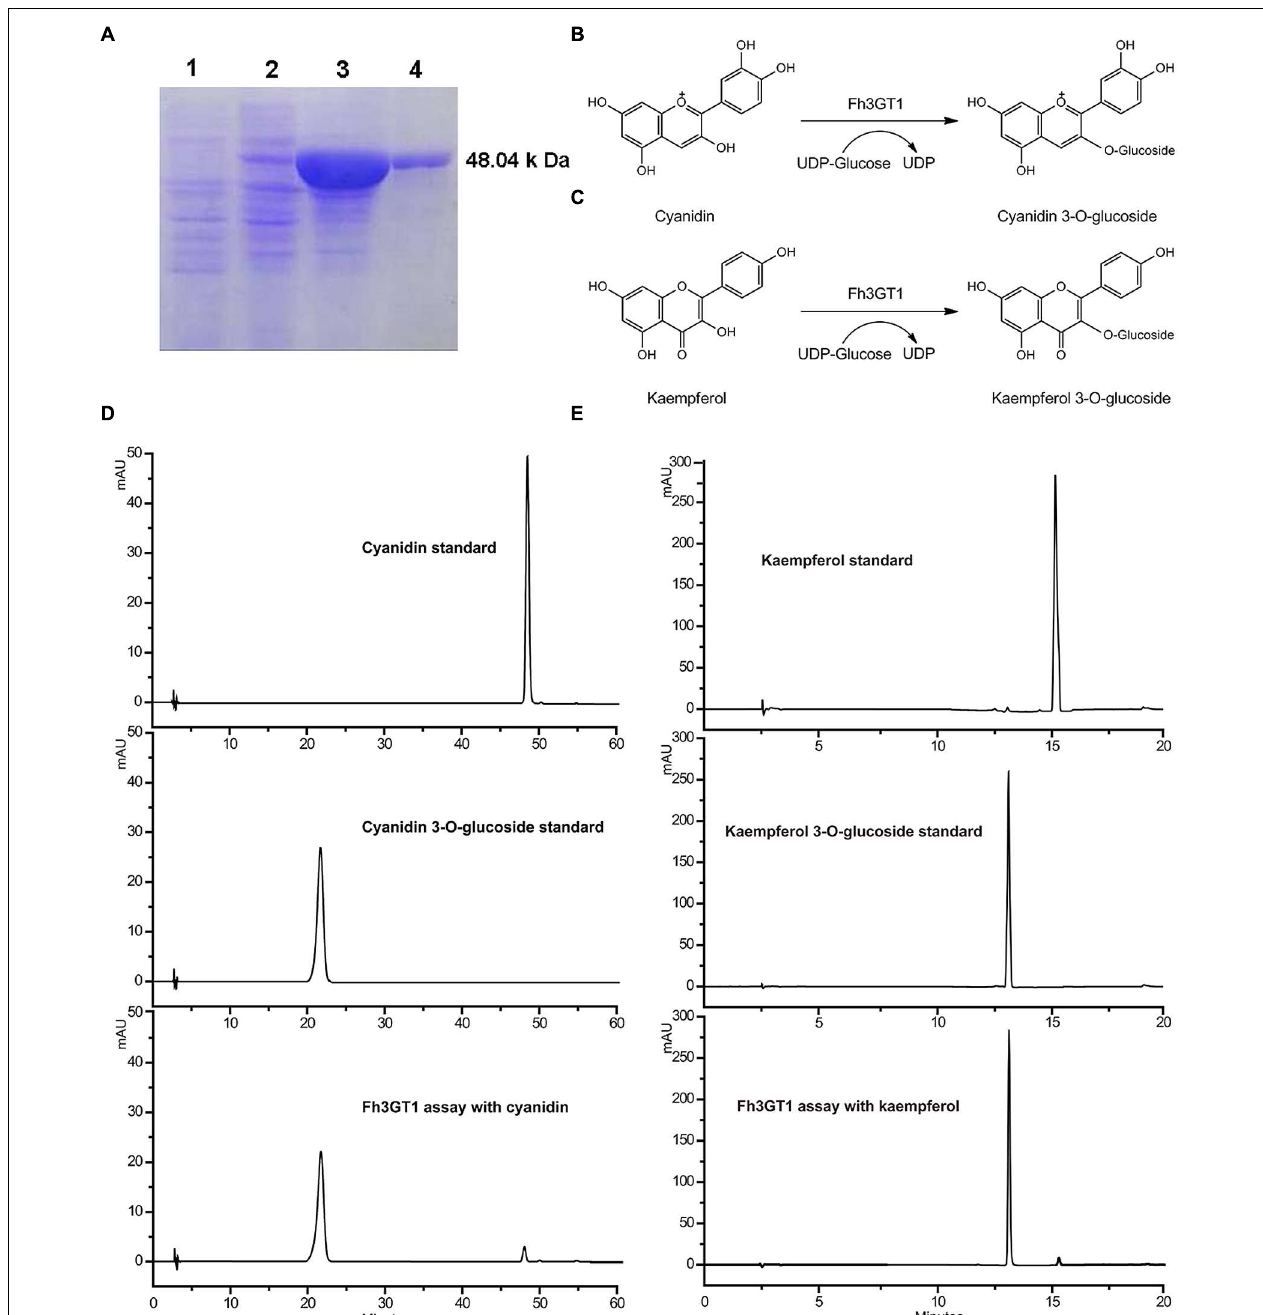
FIGURE 4 | Purification of recombinant Fh3GT1 and identification of reaction products. (A) Expression of Fh3GT1 in E. coli . (1) total soluble protein from E. coli expressing pET-28a ( + ) vector (2) total soluble protein from E. coli expressing Fh3GT1 prior to induction with IPTG (3) 50 h after induction (4) purified Fh3GT1. (B,C) Reaction scheme of the enzymatic synthesis of cyanidin/kaempferol 3- O -glucoside from cyanidin/kaempferol and UDP-glucose. (D,E) HPLC analysis of the activities of Fh3GT1 toward cyanidin and kaempferol.